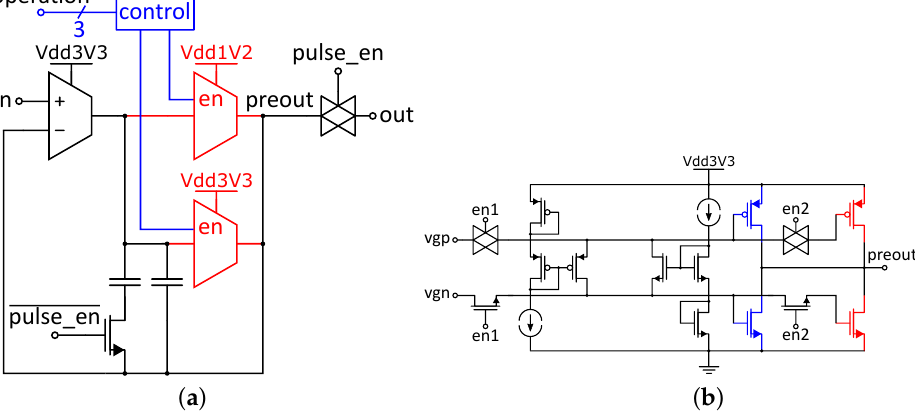
Figure 5. Operational Amplifier: ( a ) block diagram of the amplifier ( b ) circuit of the 3.3V output